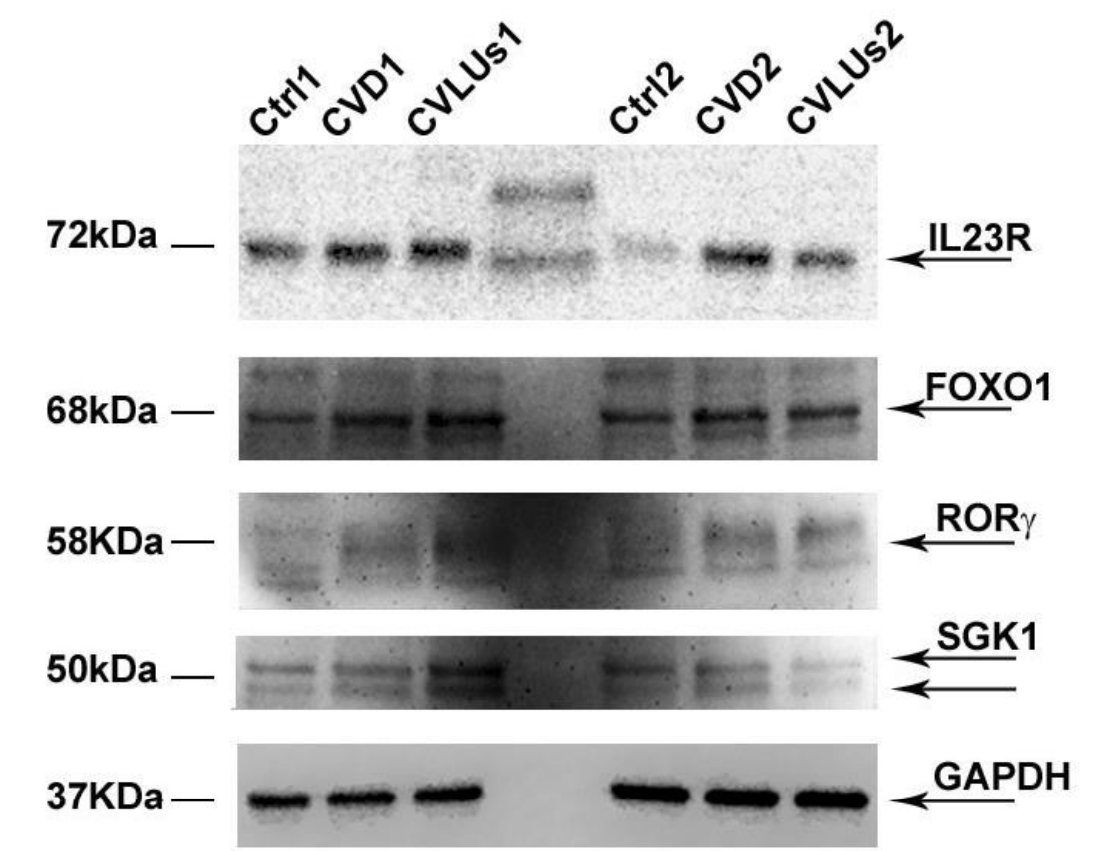
Figure 2. Western blot analysis derived from PBL protein extracts of the controls (No. 2), the CVD patients (No. 2) and CVLUs (No. 2), enrolled in the study. The results normalized for GAPDH show protein expression levels of IL23R, FOXO1, RORg, and